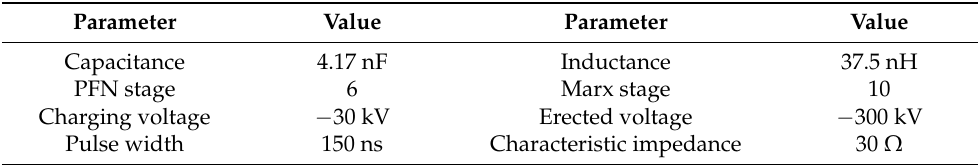
Figure 3. Picture of the 10-stage PFN-Marx generator. Table 1. Design parameters of the 10-stage PFN-Marx generator.